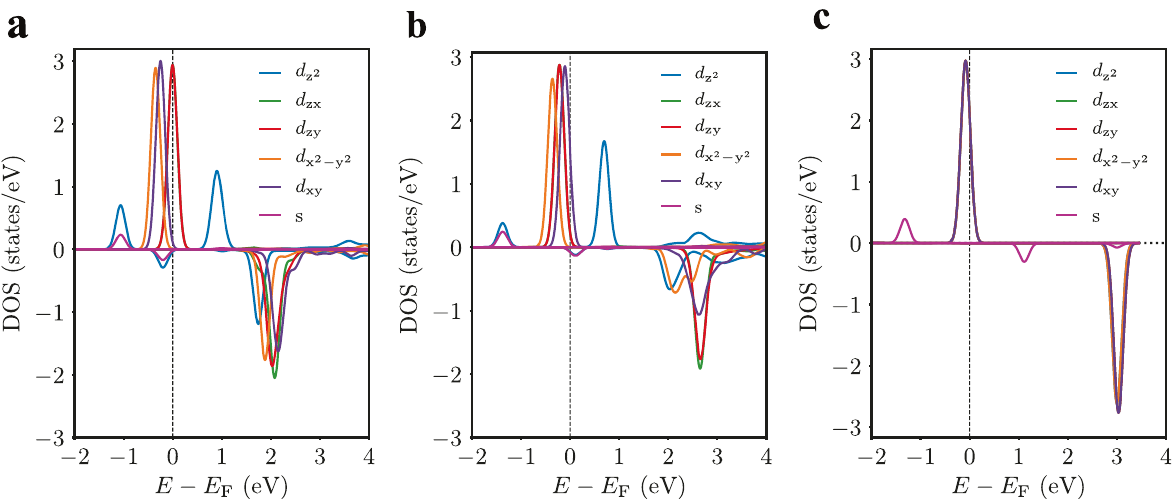
Fig. 5 Thickness dependence of the electronic structure of a V adatom on MgO in the oxygen-top position. a One monolayer of MgO. b Two monolayers of MgO. c Free